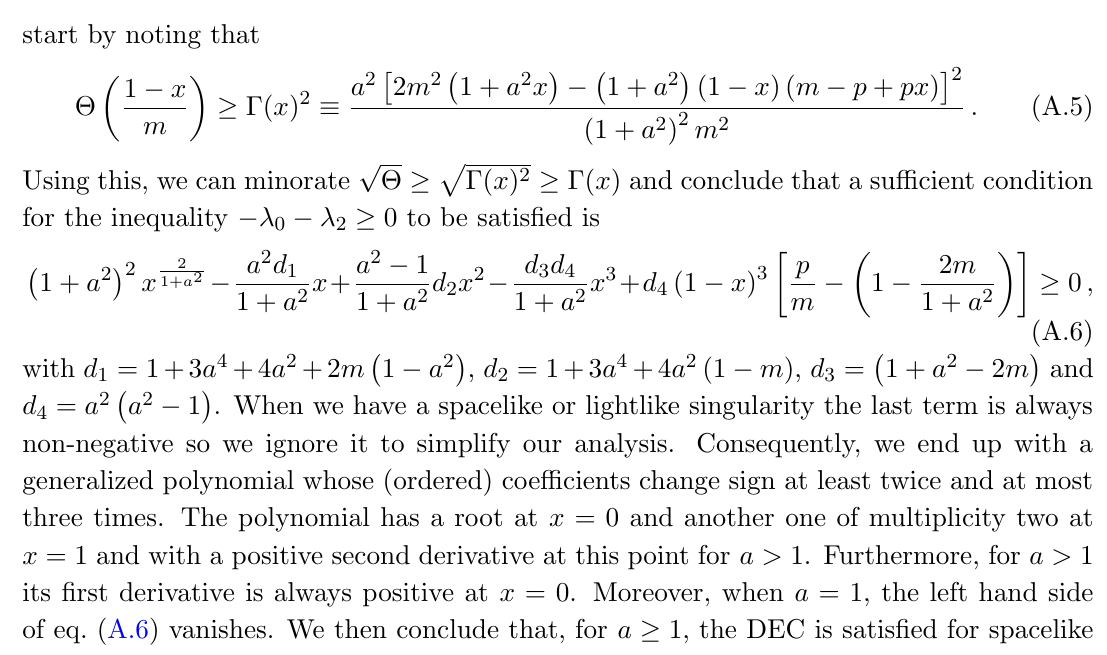
Figure 3 . The shaded areas indicate regions in the parameter space where the WEC is violated, for various values of the dilaton coupling 0 < a < 1. For a > of (cid:12)gure 2 because the additional condition (cid:0) (cid:21) 0 (cid:21) 0 imposes no further constraints. For a < the WEC is more restrictive than the NEC and the violation regions consequently become more intricate. Note the smallness of vertical